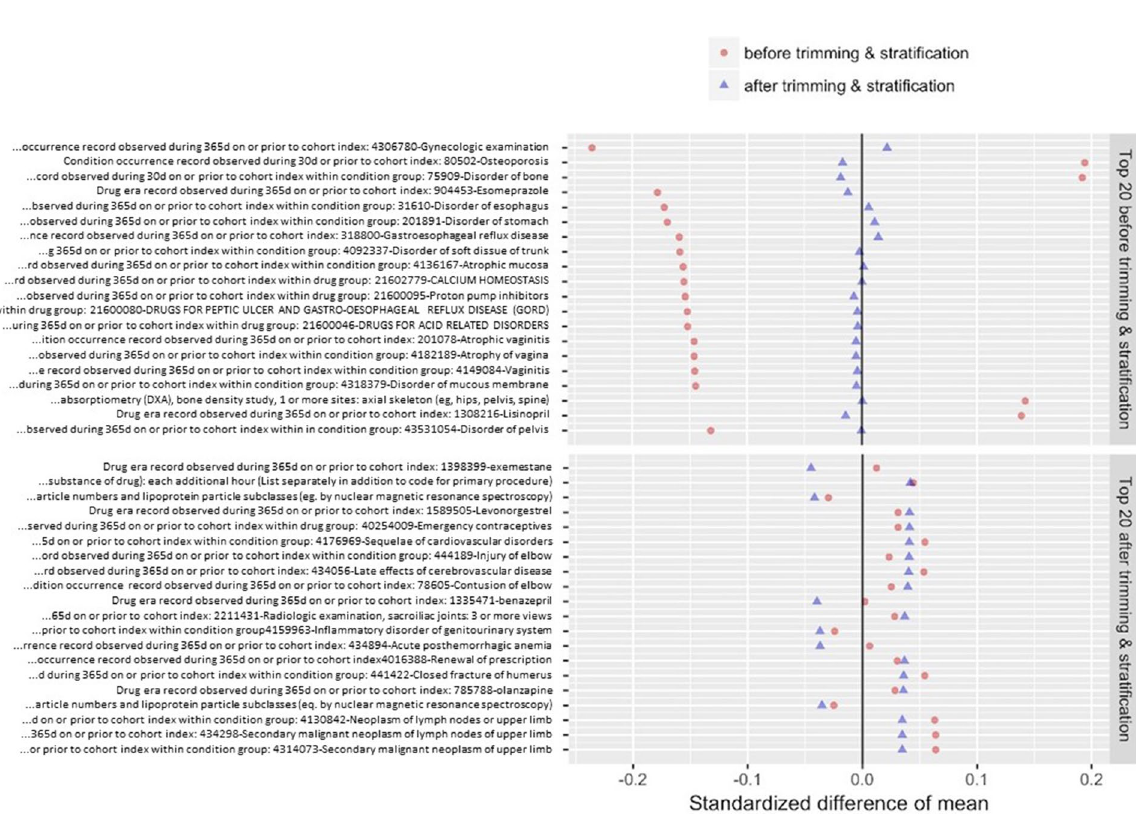
Fig. 3. P-Plus: most unbalanced covariates before (top) and after (bottom) PS trimming and